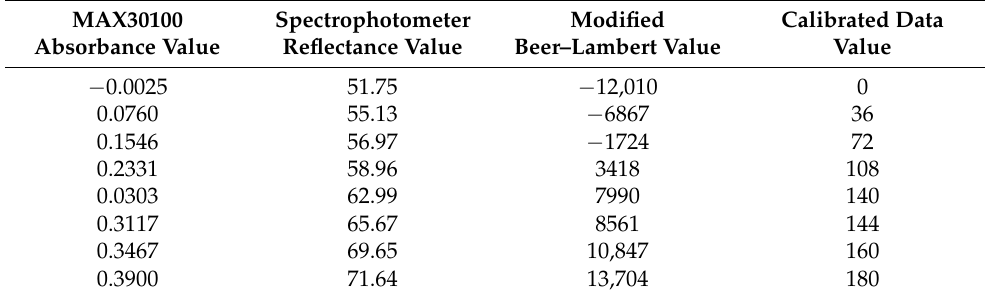
Table 5. Calibrated